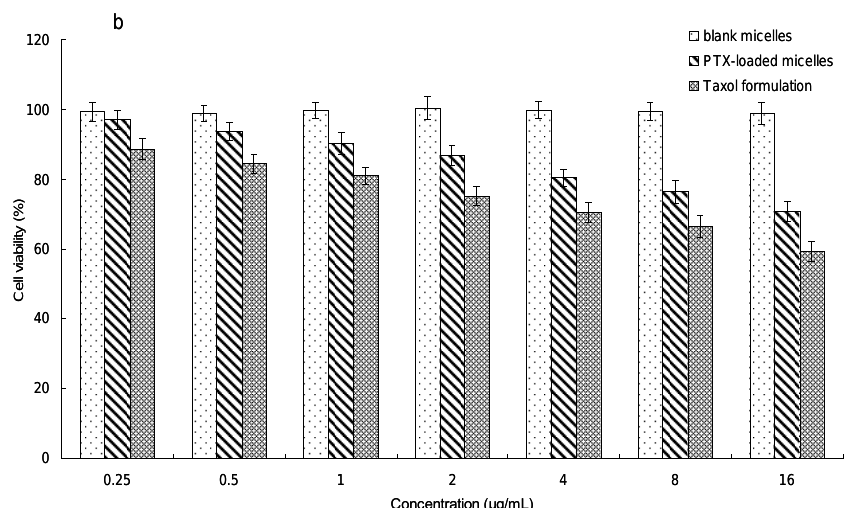
Figure 8. In vitro cytotoxicity of PTX-loaded mPEG-CS(SH)-CHO micelles against ( a ) MCF-7 cells and ( b ) peripheral blood mononuclear cells (PBMC).